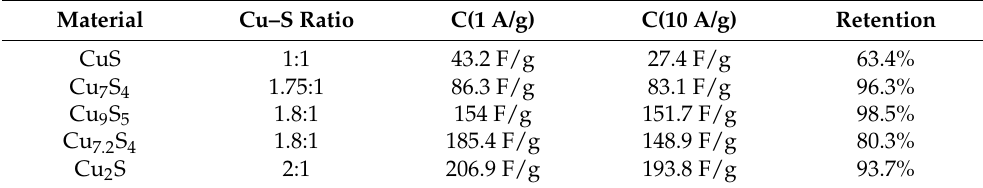
Table 1. The capacitance capability of different materials with the same morphology (CuS, Cu 9 S 5